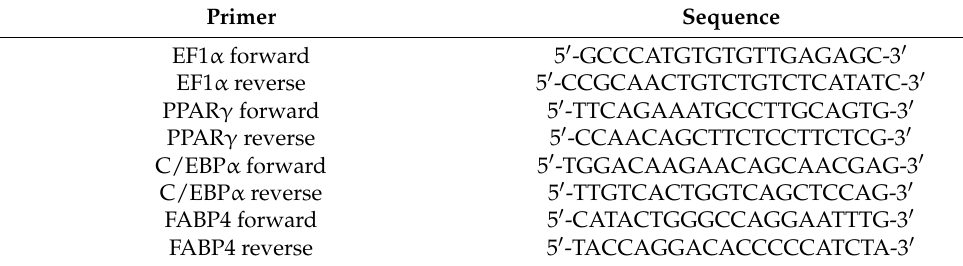
Table 1. Primer sequences for